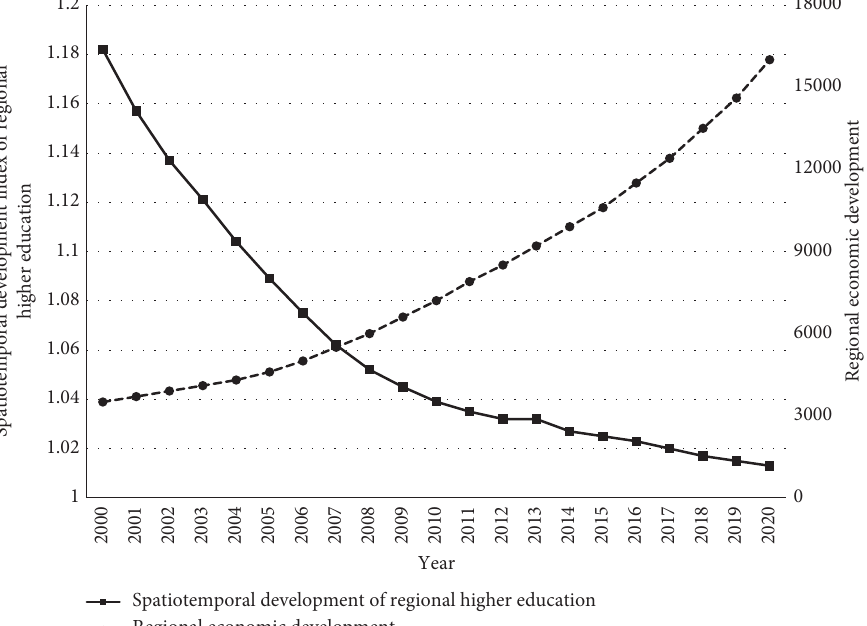
Figure 7: Spatiotemporal evolution trends of spatiotemporal difference of higher education, input of higher education, and regional economic